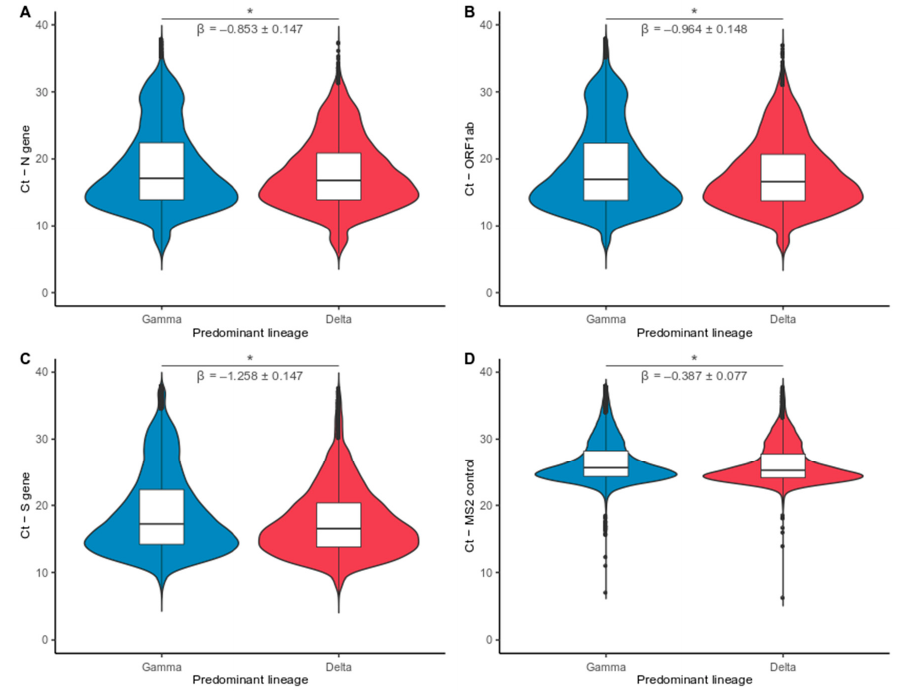
Figure 4. Comparative analysis of reverse transcription-quantitative polymerase chain reaction (RT-qPCR) cycle threshold (Ct) values between Gamma and Delta dominated periods. Violin plots displaying the distribution of Ct data for different Variants of Concern (VOCs) for three viral targets and internal control: ( A ) N gene; ( B ) ORF1ab; ( C ) S gene; and ( D ) MS2 control. Sample groups were input as Gamma (blue) and Delta (Red) when the variant exhibited frequency above 90%. Statistical comparison between periods denotes that Delta VOC induces higher viral loads in the upper respiratory tract than Gamma VOC infection. Internal control (MS2) had an effect two–three fold smaller on Ct decrement than reported for all viral targets. Asterisks indicate a significant statistical association between imputed viral lineages and Ct values (linear model: p < 0.001). * p < 0.05.